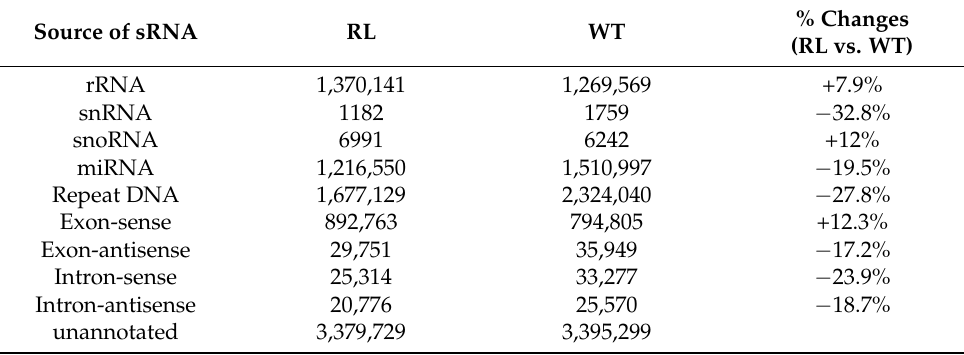
Table 1. Summary of sRNAs in differentially accumulated sRNA clusters.